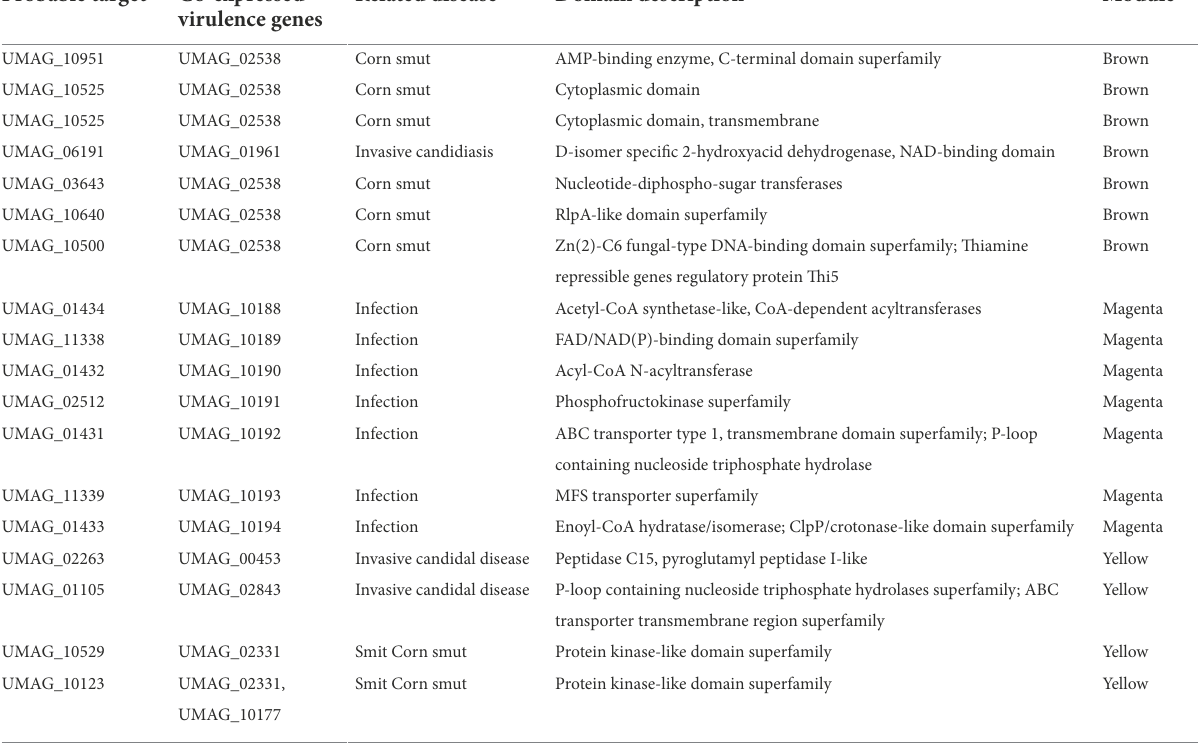
TABLE 3 Probable targets most co-expressed with virulence genes. Probable